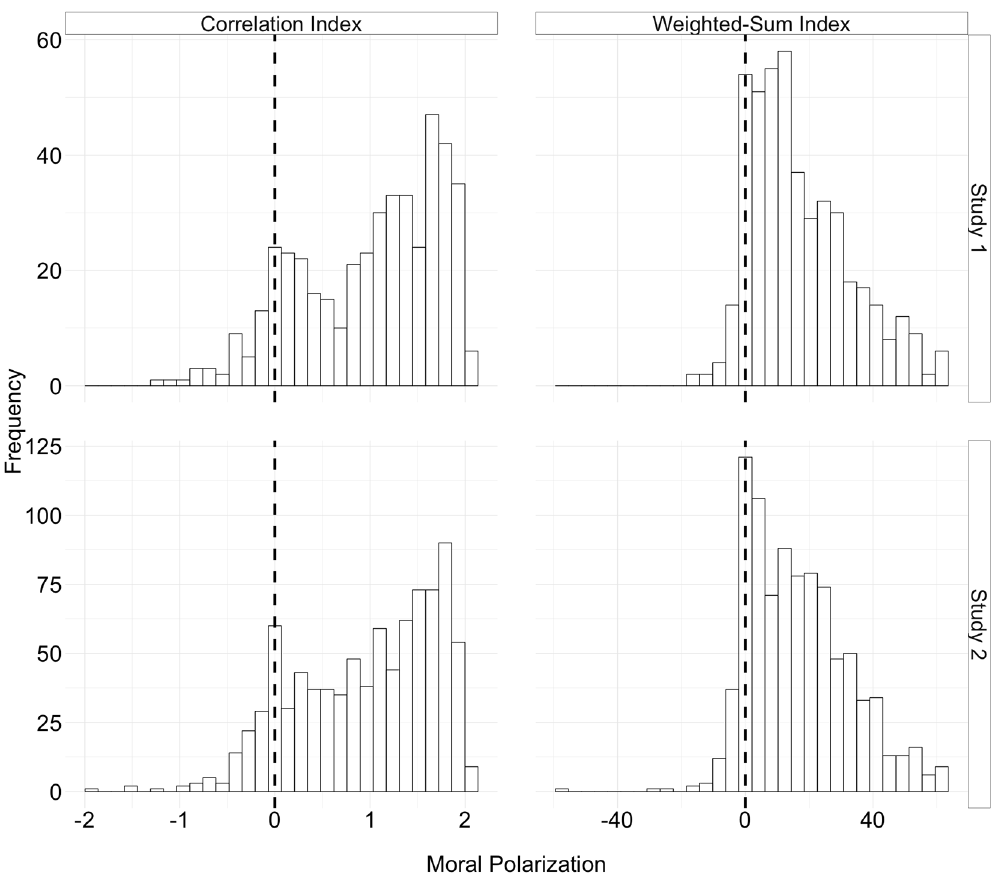
Figure 2. Distribution of moral polarization values according to each index in Studies 1 and 2. Note. Each subject has a single value in each panel. Correlation Index: Study 1 N = 442, Study 2 N = 874; Weighted-Sum Index: Study 1 N = 454, Study 2 N =